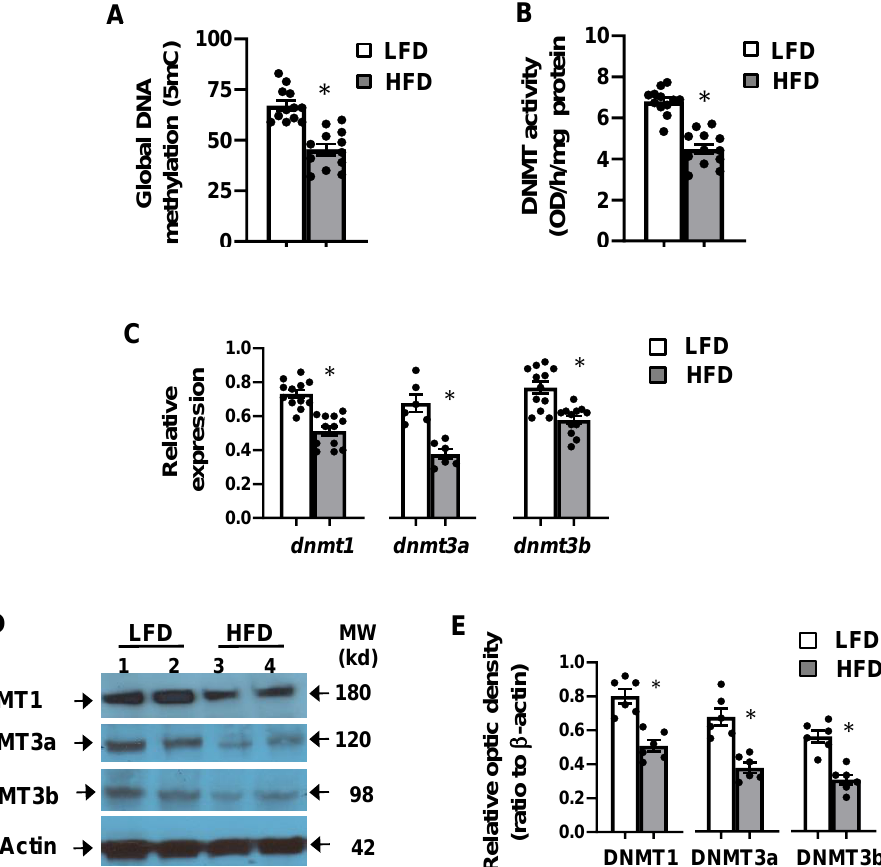
Figure 3. High-fat diet altered DNA methylation, and DNA methyltransferases (DNMT) activity and expression. ( A ) Global DNA methylation ( n = 12) and ( B ) activity ( n = 12) and ( C ) mRNA abundance of DMNT ( n = 12). ( D ) Representative protein blots and ( E ) optic density of protein bands ( n = 6) of hepatic DNMT of mice fed LFD and HFD diets. Statistical difference was assessed with unpaired t-test with * p < 0.05.